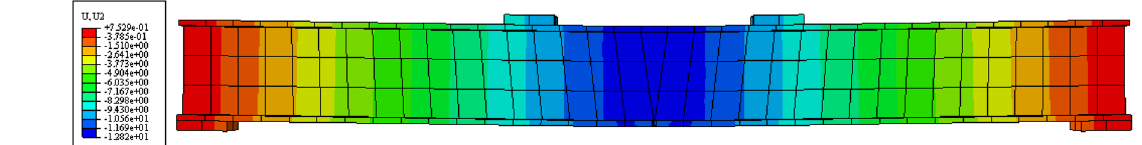
Figure 15. Residual deflection after overloading.